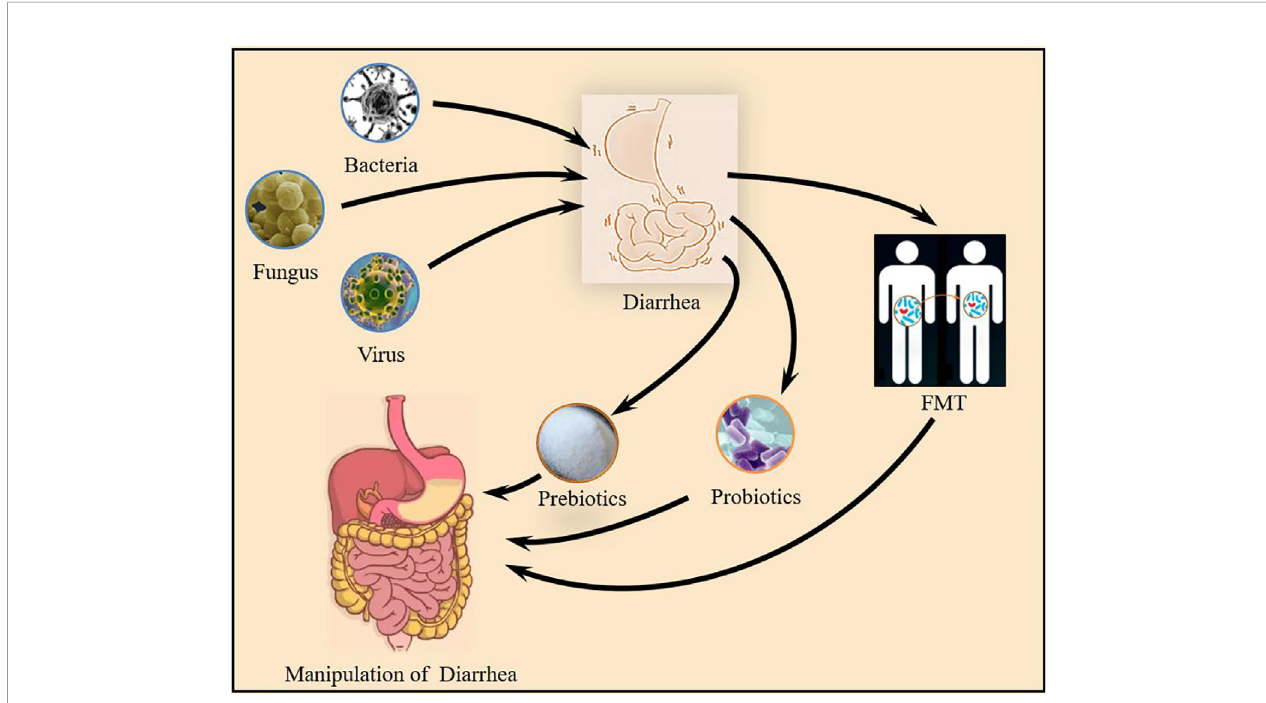
FIGURE 1 | Gut microbiota and diarrhea: Bacteria, Fungus and Virus all mediate the occurrence of diarrhea. microbial intervention by prebiotics, probiotics and FMT can regulate the composition of the intestinal fl ora to prevent and improve the occurrence of